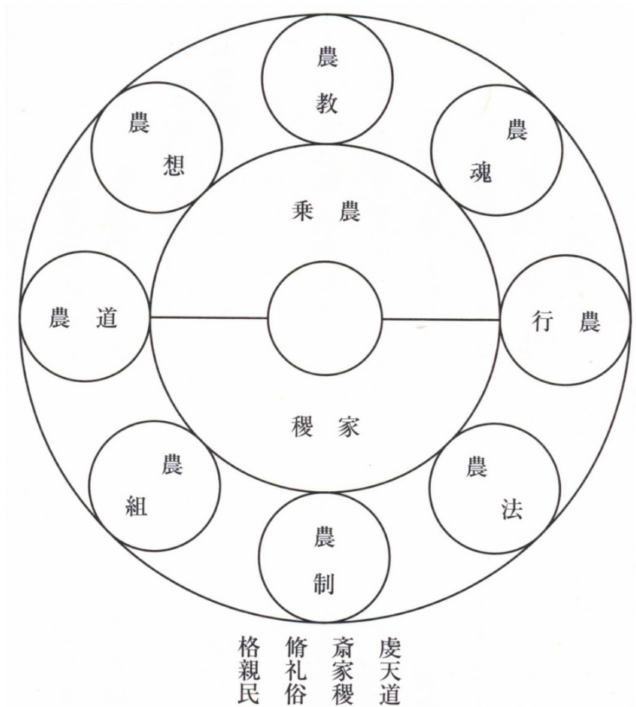
Figure 1. Eto Tekirei’s “Wheel of household grain farming” (Wada 2012, p.